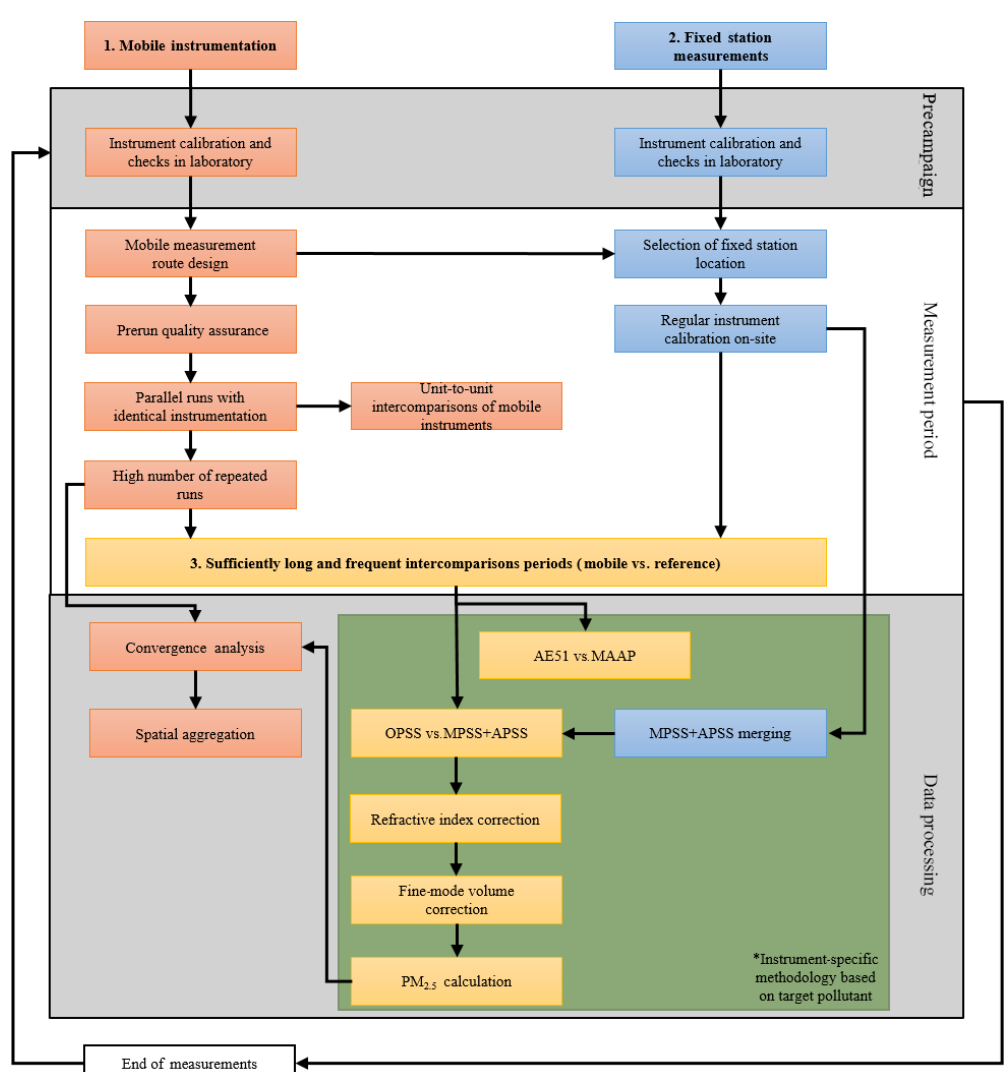
Figure 1. Methodology for highly quality assured mobile measurements. The task box colors distinguish methods 1, 2, and 3 while the color of the background separates the period of the application of each method. The green box represents the items in the methodology that are instrument-specific. For the purposes of this article, the items within the green box are tailored for eBC and PM measurements from AE51 and OPSS,